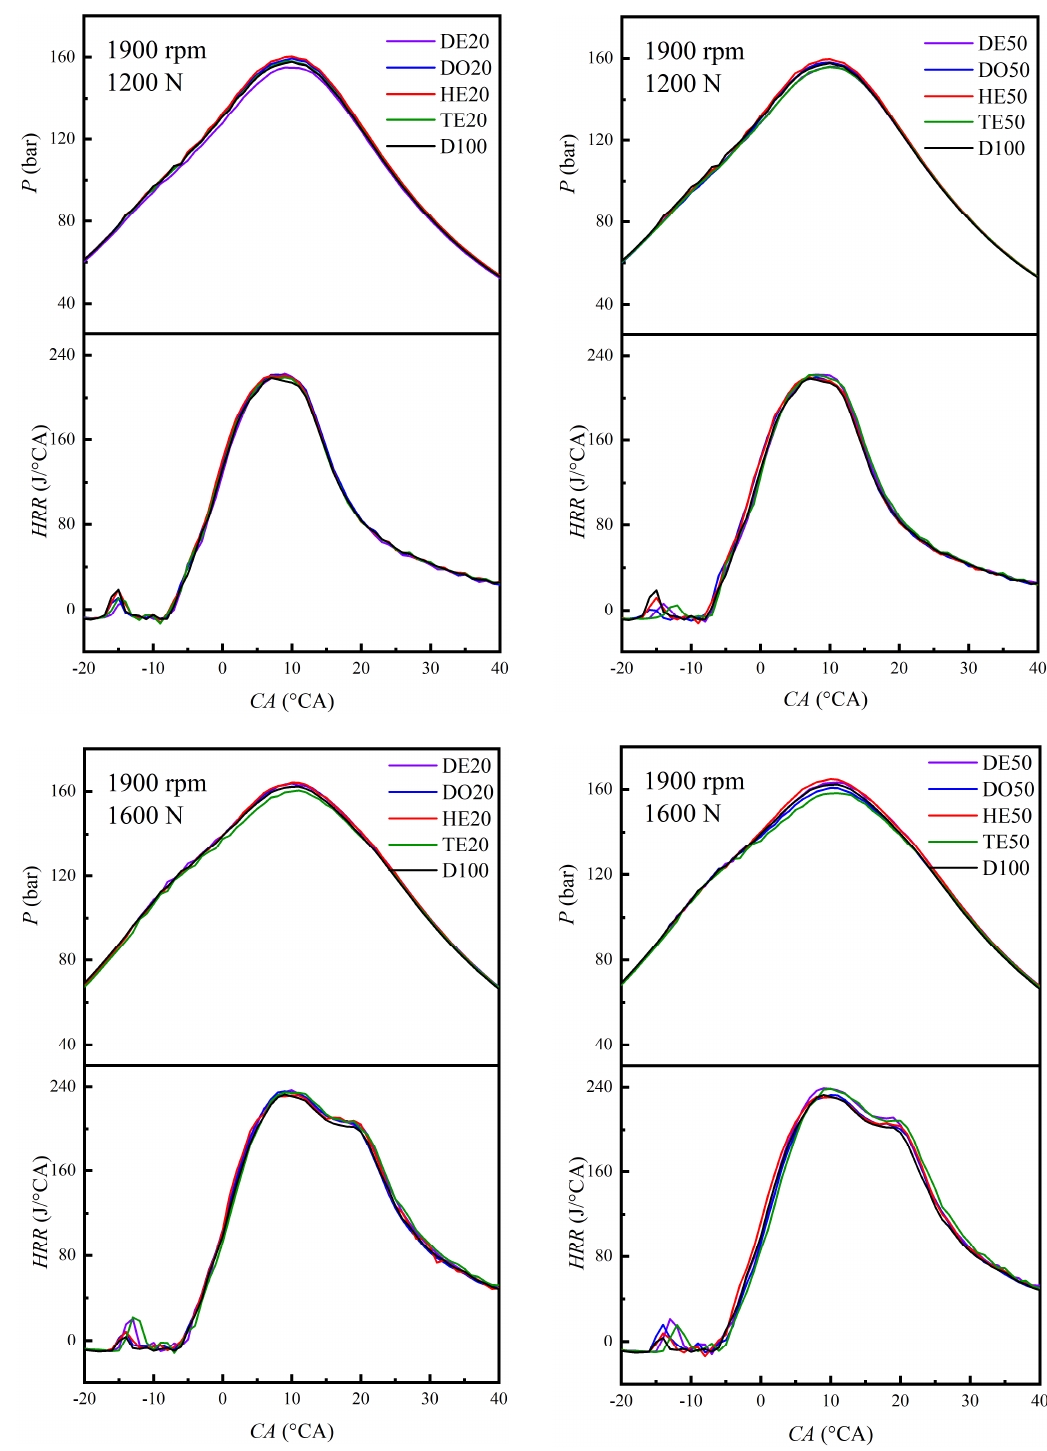
Figure 8. The curves of in-cylinder and HRR at 1900 rpm.